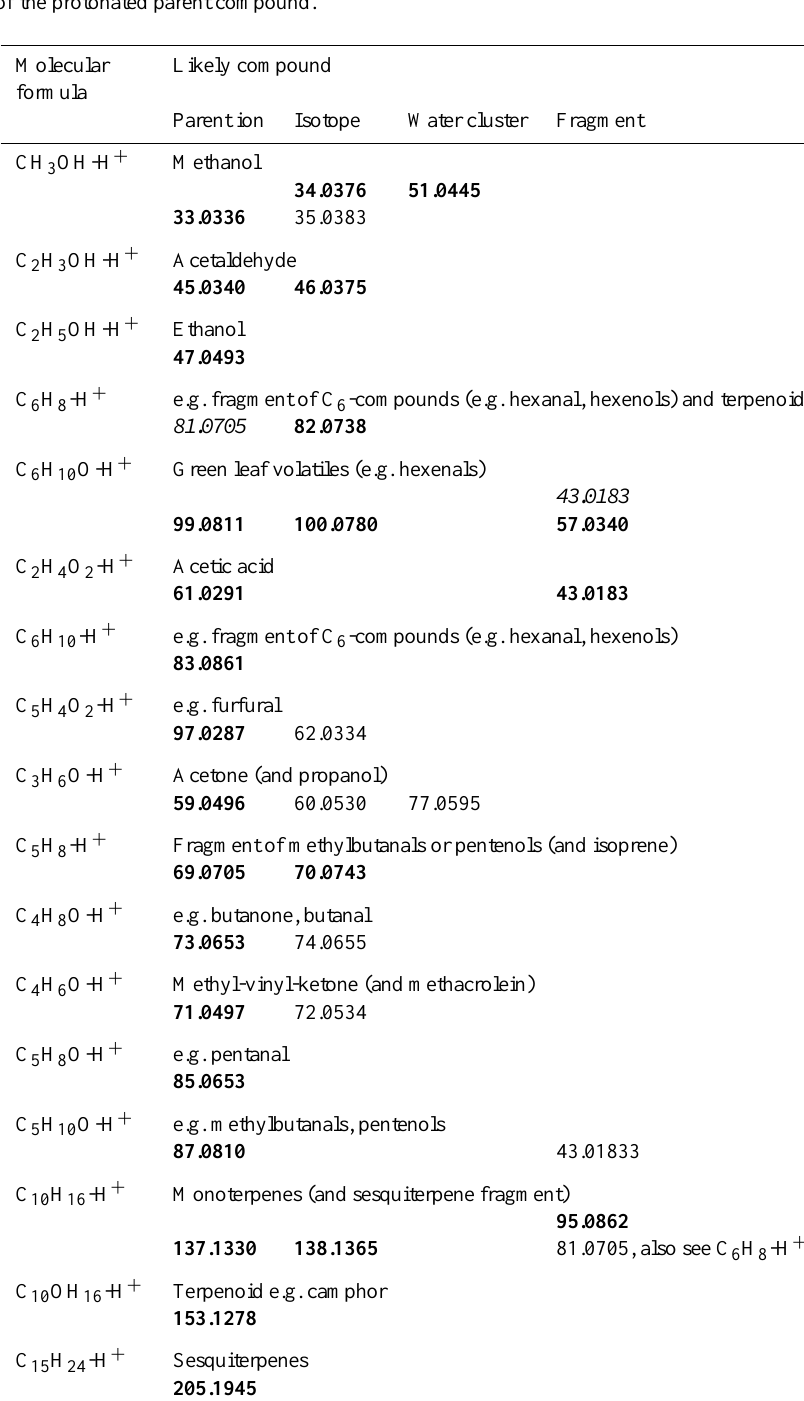
Table 1. Volatile organic compounds with emission or deposition flux above the grassland before, during or after harvesting, exact measured m/z of well defined class-A fluxes (bold) or only less reliable class-B fluxes, exact mass of parent ion mass peak, isotopes, VOC-water clusters and fragments of the protonated parent